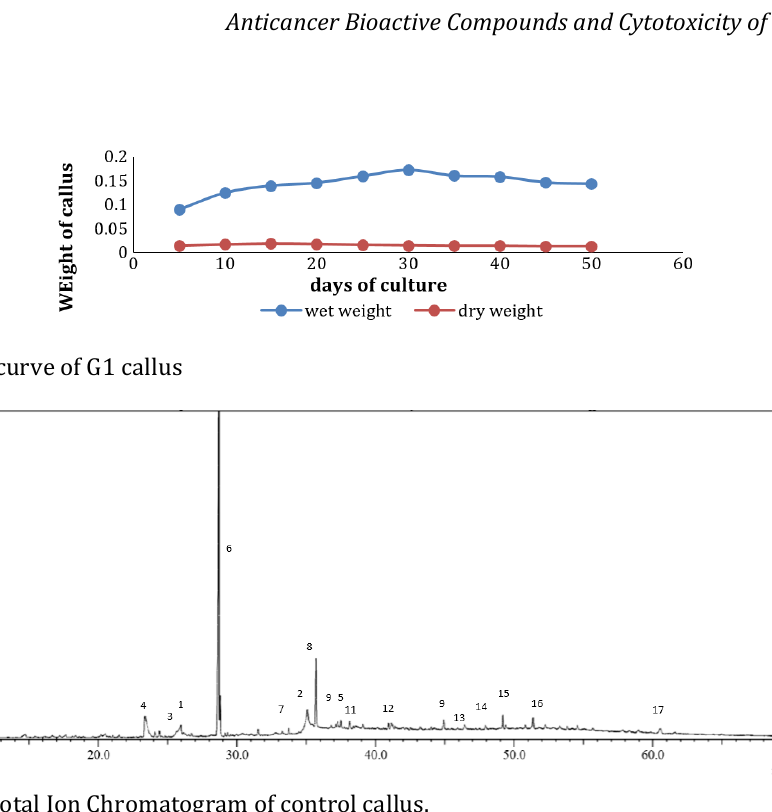
Figure 2. GC-MS Total Ion Chromatogram of control callus.